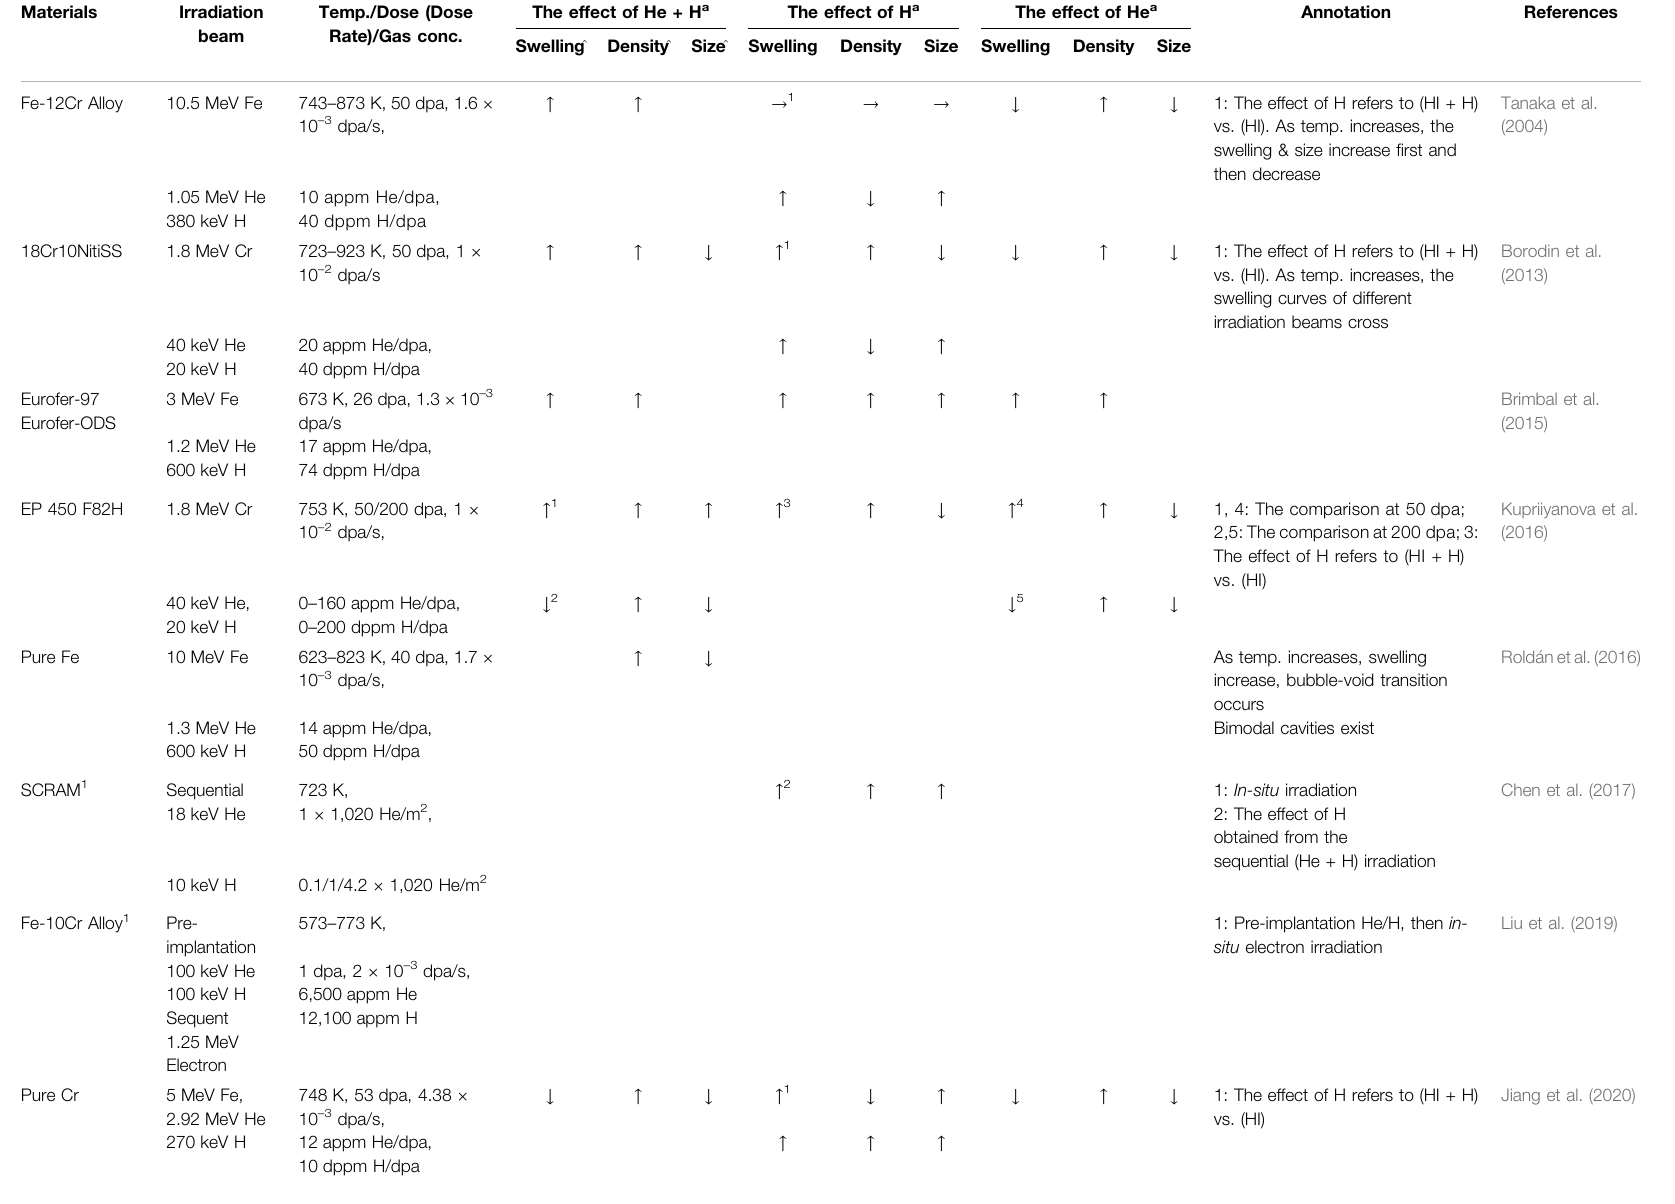
TABLE 1 | ( Continued ) The summary of typical studies on the He-H synergistic effects under multi-ion beam